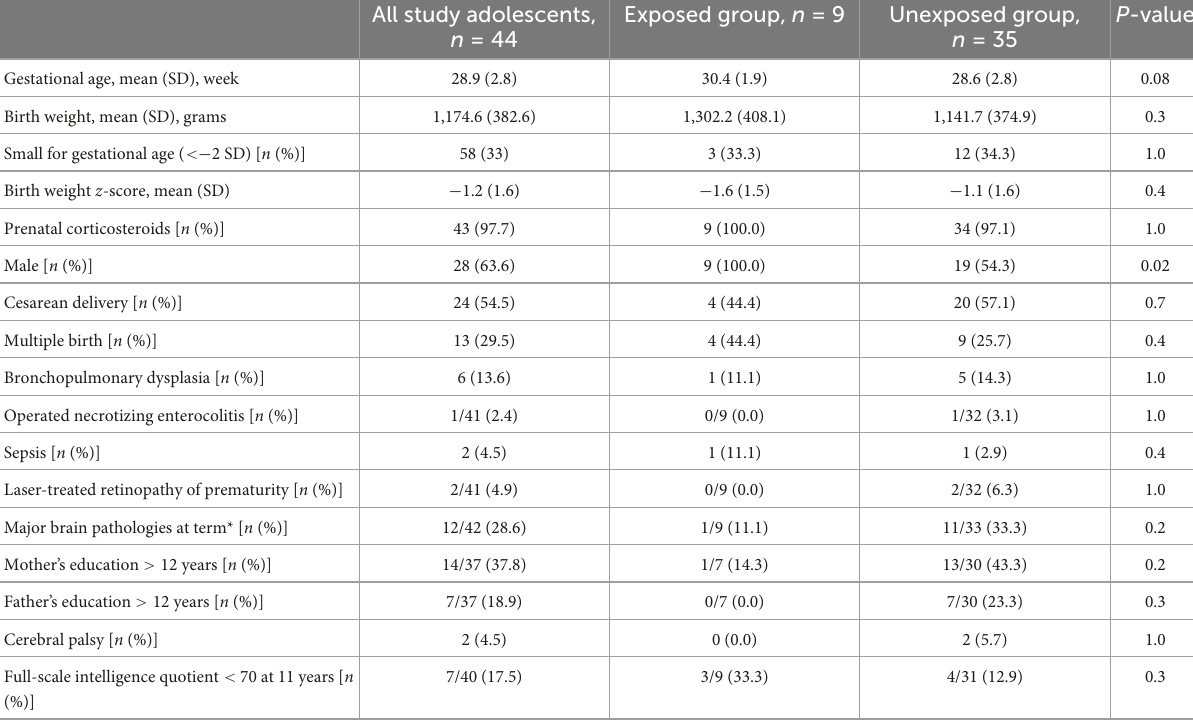
TABLE 1 Perinatal background characteristics of all study adolescents born very preterm (gestational age < 32 weeks and/or birth weight ≤ 1,500 g), and comparison between those exposed and unexposed to maternal smoking during pregnancy ( p -value). All study adolescents, Exposed group, n = 9 n = 44